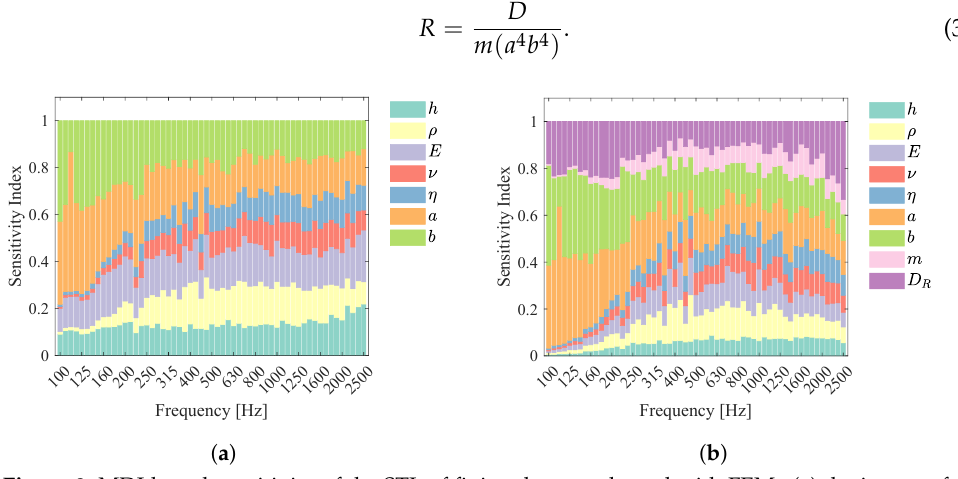
Figure 8. MDI-based sensitivity of the STL of finite plates evaluated with FEM: ( a ) the inputs of the surrogate only consist of the STL variables ( RMSE = 5.76 ± 0.06 dB); ( b ) physics-guided features m and D R are included as input for the surrogate ( RMSE = 5.60 ± 0.06 dB).